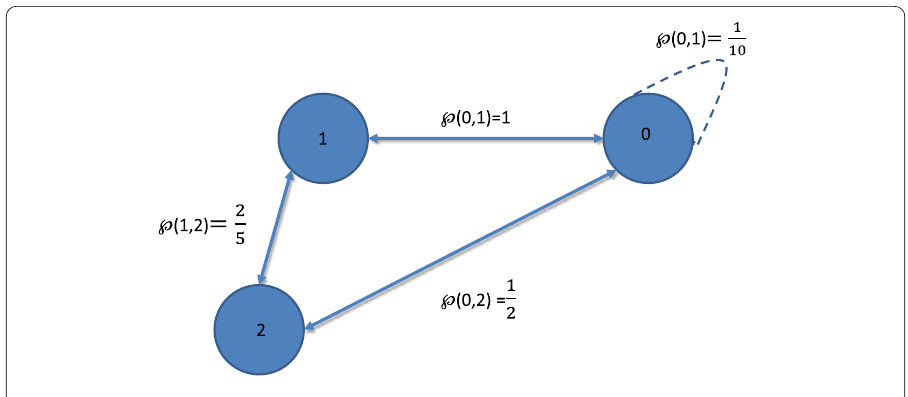
Figure 1 Controlled metric-like space as in Example